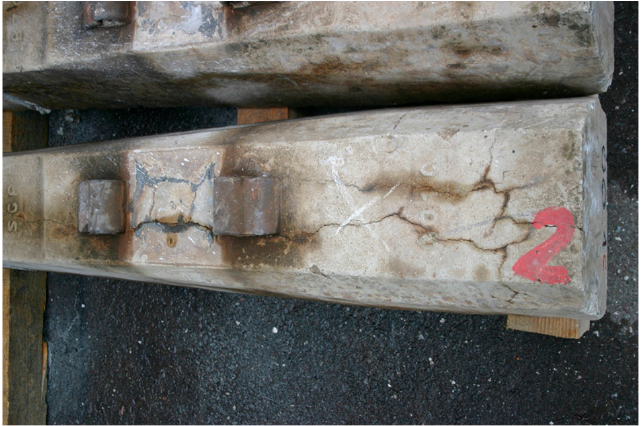
Figure 1. Typical cracks in the prestressed reinforced concrete railway sleepers investigated. Three sets of monitoring equipment were